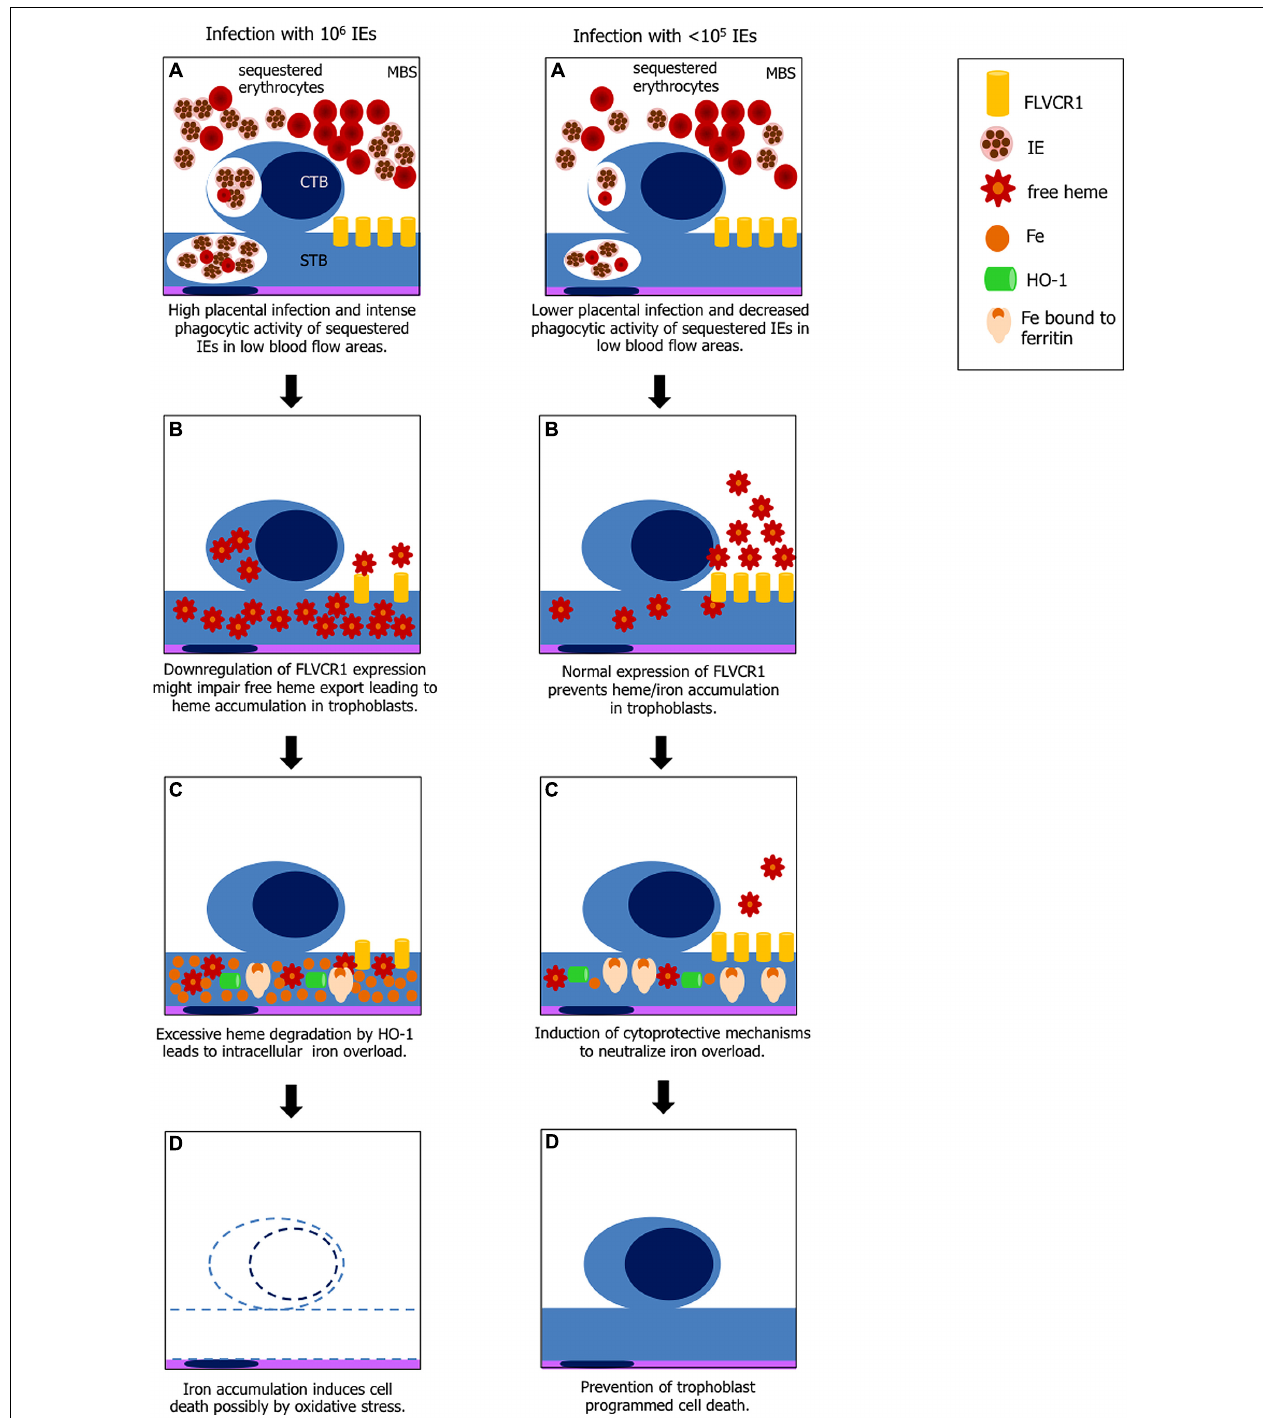
export; (C) heme catabolism by HO-1 generates large amounts of iron which may exceed ferritin binding capacity; (D) free iron (Fe 2 + ) induces cell death by ROS. Right panel: (A) lower placental infection might not affect FLVCR1a expression and phagocytosis is decreased; (B) excessive free heme is exported from the cell; (C) iron from heme catabolism is neutralized by ferritin; and (D) trophoblasts are protected from programmed cell